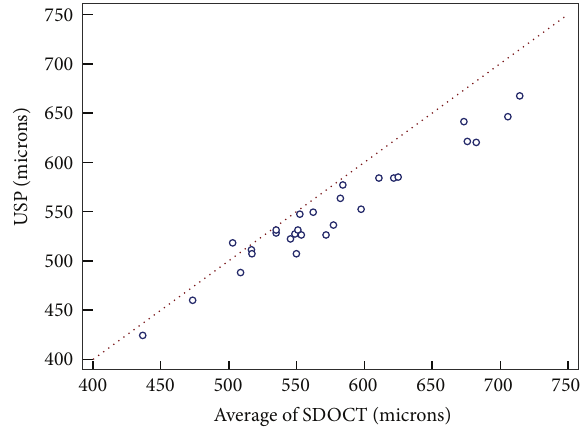
Figure 3: Scatter plot of correlation between mean SD-OCT and USP